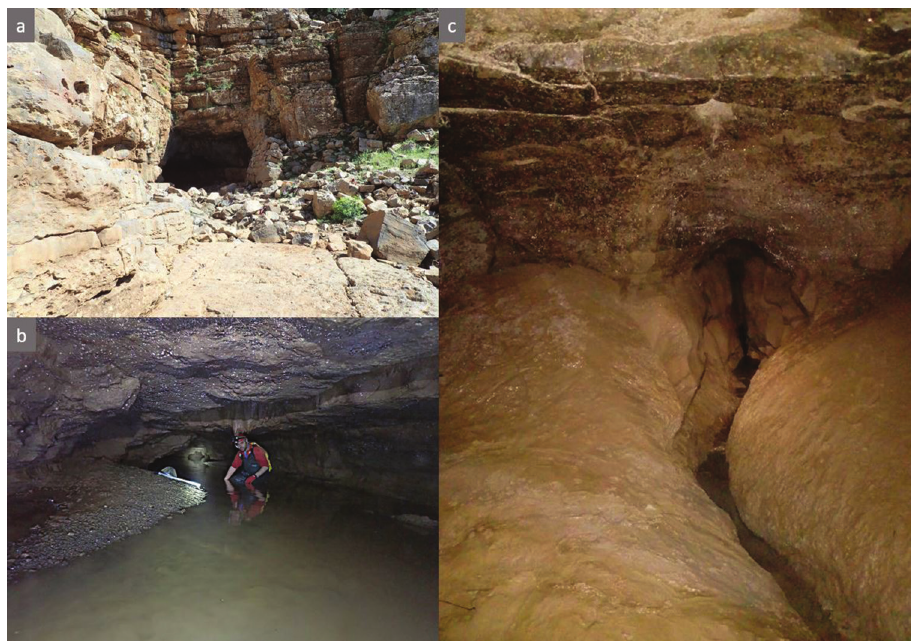
Figure 1. Study area Ait M’hamed cave a The cave entrance b the sampling and c the inside of the cave (Moutaouakil 2019).